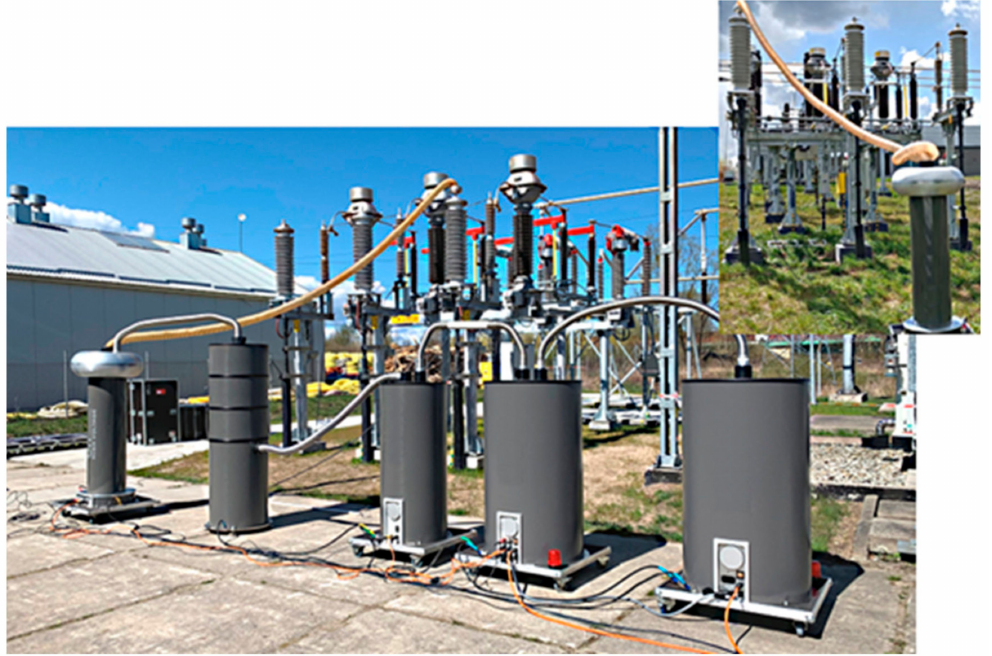
Figure 4. Test setup with the DAC system connected to the 110 kV cable phase under test at the near end and an additional PD detector at the remote end of the same cable